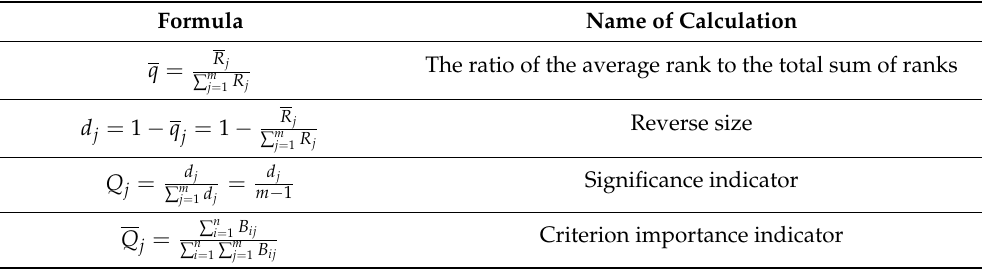
Table 6. Formulas for calculating the importance of criteria (source: compiled by authors based on)